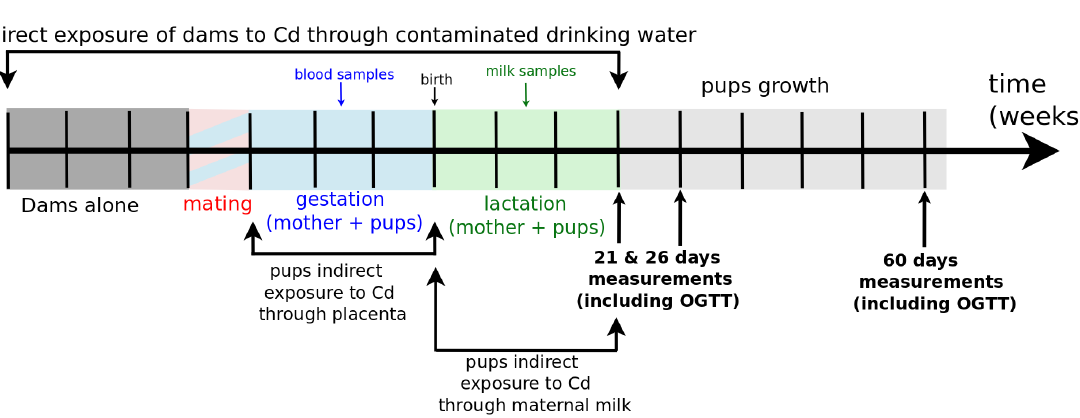
Figure 1. Protocol for indirect exposure of rat litters to cadmium through their